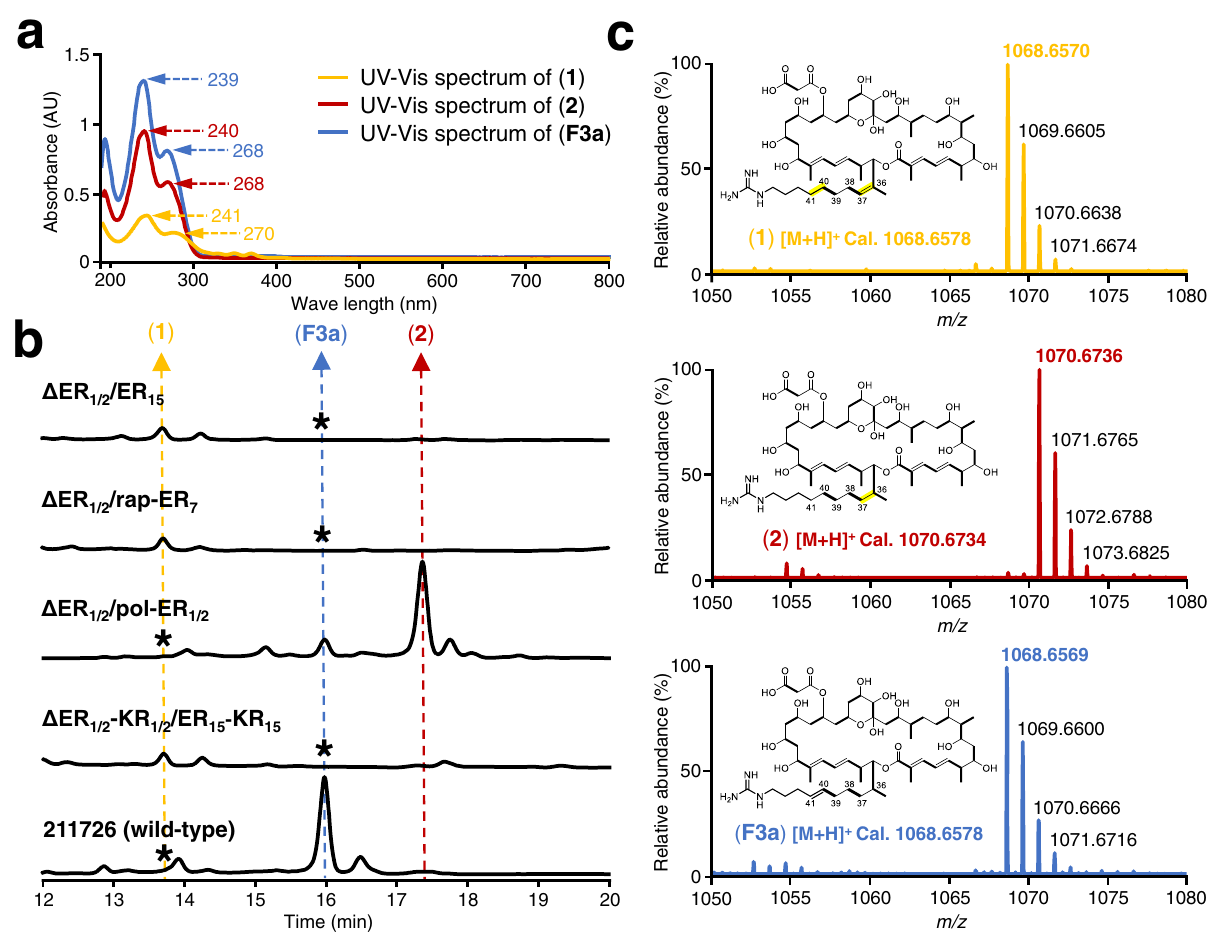
Fig. 2 | Product analysis of strains with ER domain replacements. a UV/Vis spectra of F3a , 1 and 2 . AU is absorbance unit. b HPLC analysis at λ =254nm. The same compounds are indicated by the dotted line with same color and no corre- sponding components detected are indicated by the asterisks. c LC-ESI-HRMS